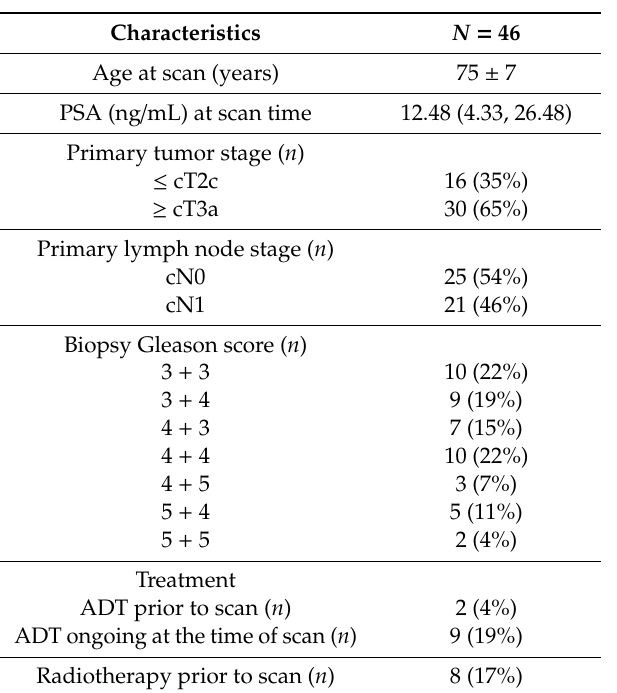
Table 1. Summary of patient